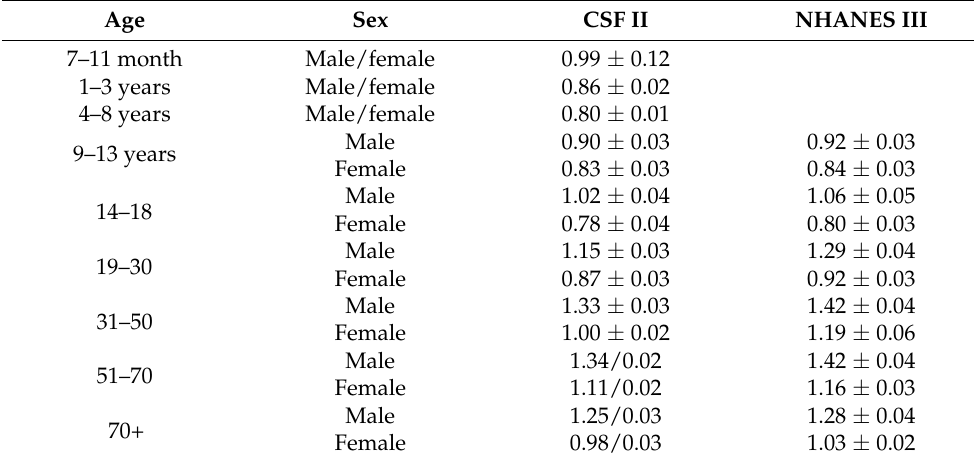
Table 8. Dietary boron intake for different ages in the US (mg